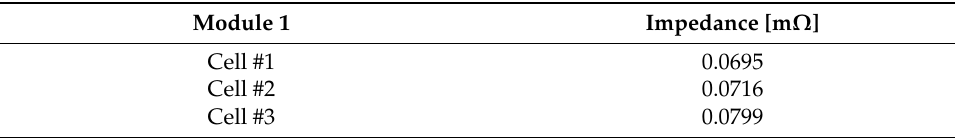
Table 2. Cell impedances for